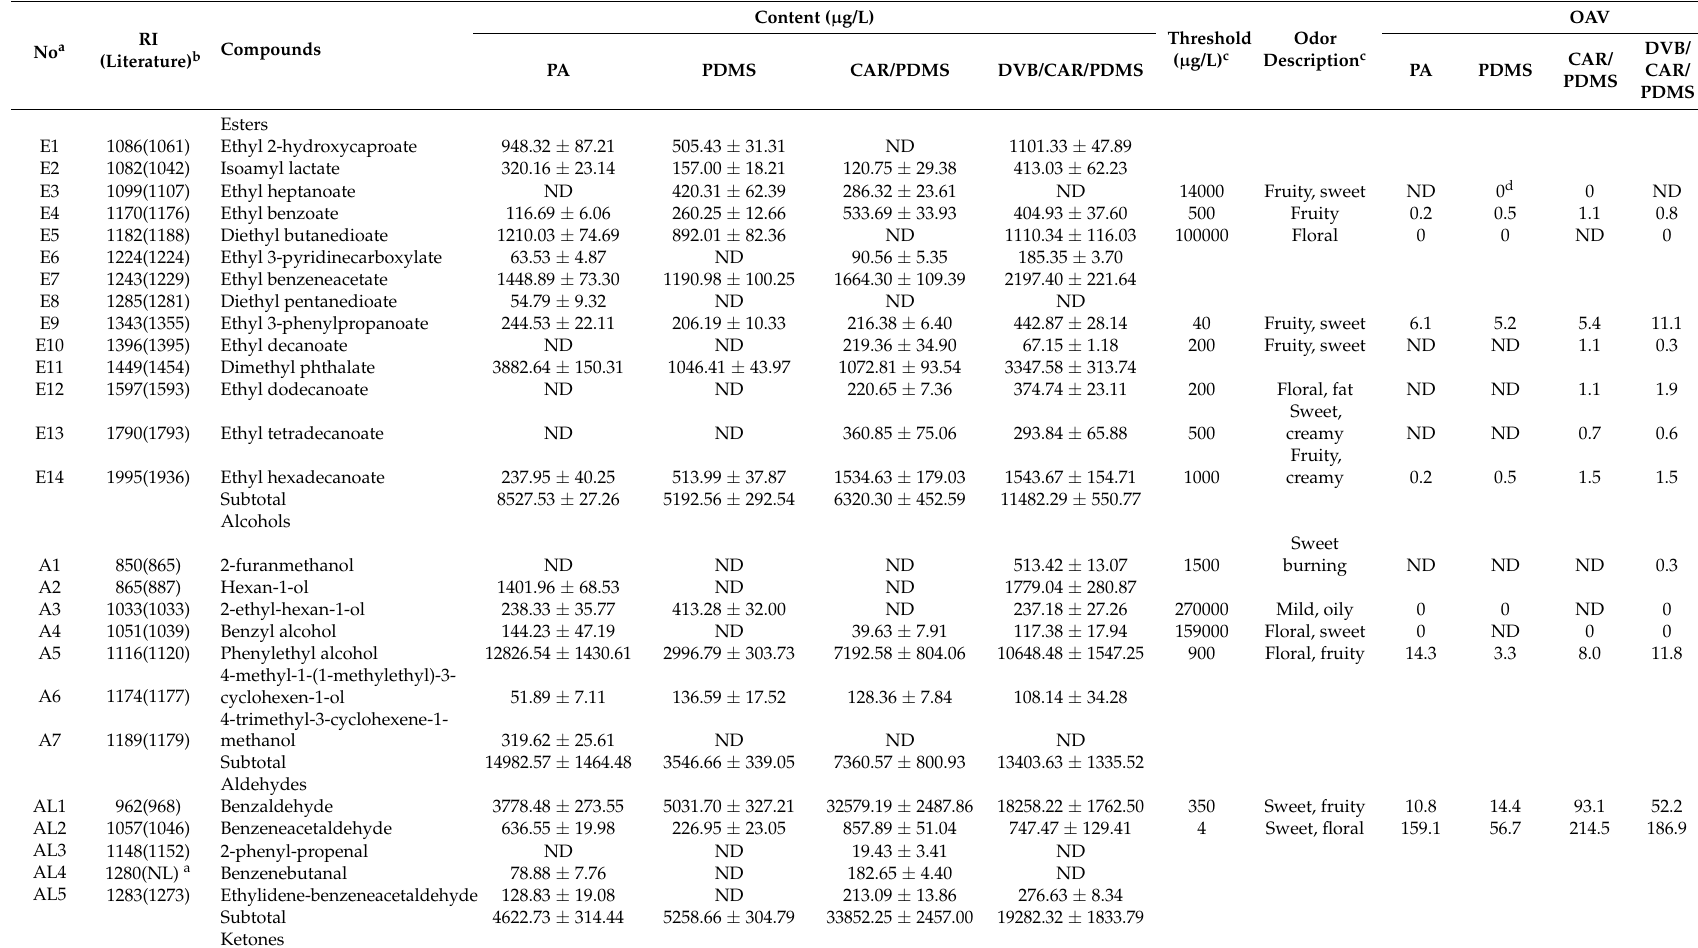
Table 1. Content and OAV of flavor compounds in proso millet wine using SPME with different fibers (n ±